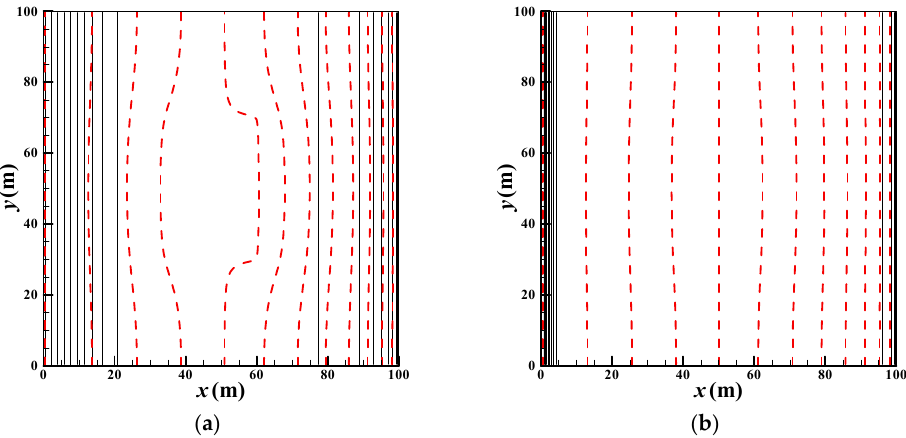
Figure 4. Pressure fields comparison at t 1 : black solid line-FDM; red dashed line-POD. ( a ) Fracture ( ε F = 18.89%); ( b ) Matrix ( ε M = 16.26%).